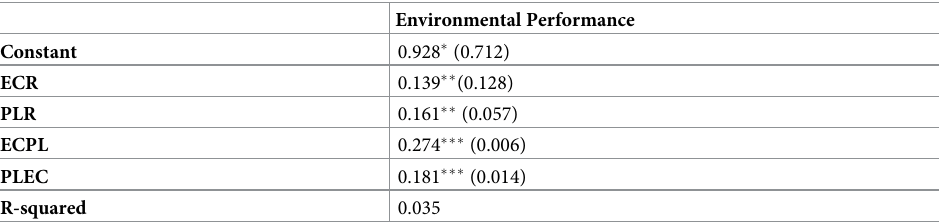
Table 4. Impact of economic and political reforms on environmental performance.